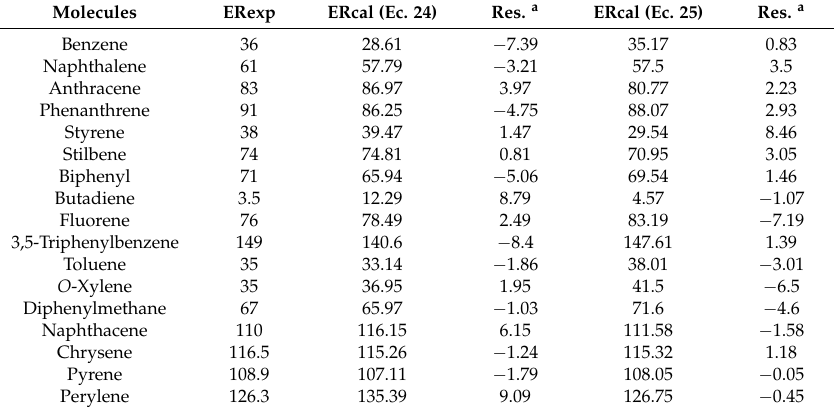
Table 12. Experimental resonance energy calculated by the GDI-based models.